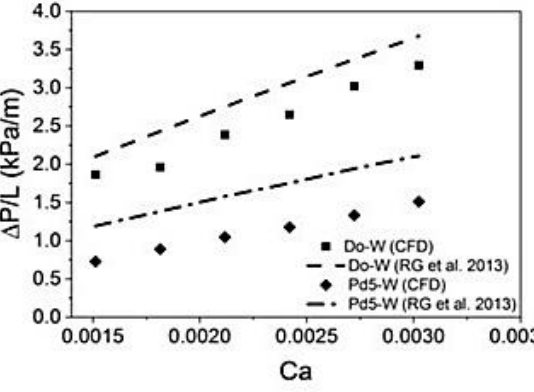
Figure 11. Comparison of pressure drop per unit length as a function of Capillary number between the present CFD results and that obtained from Eq.